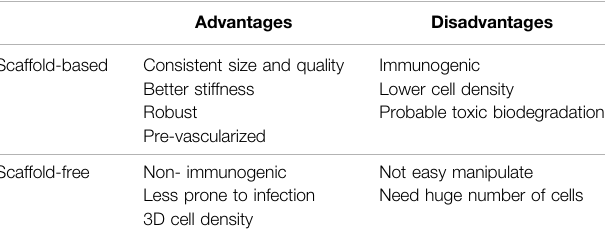
TABLE 3 | Advantages of scaffold based and scaffold free 3D bioprinting.